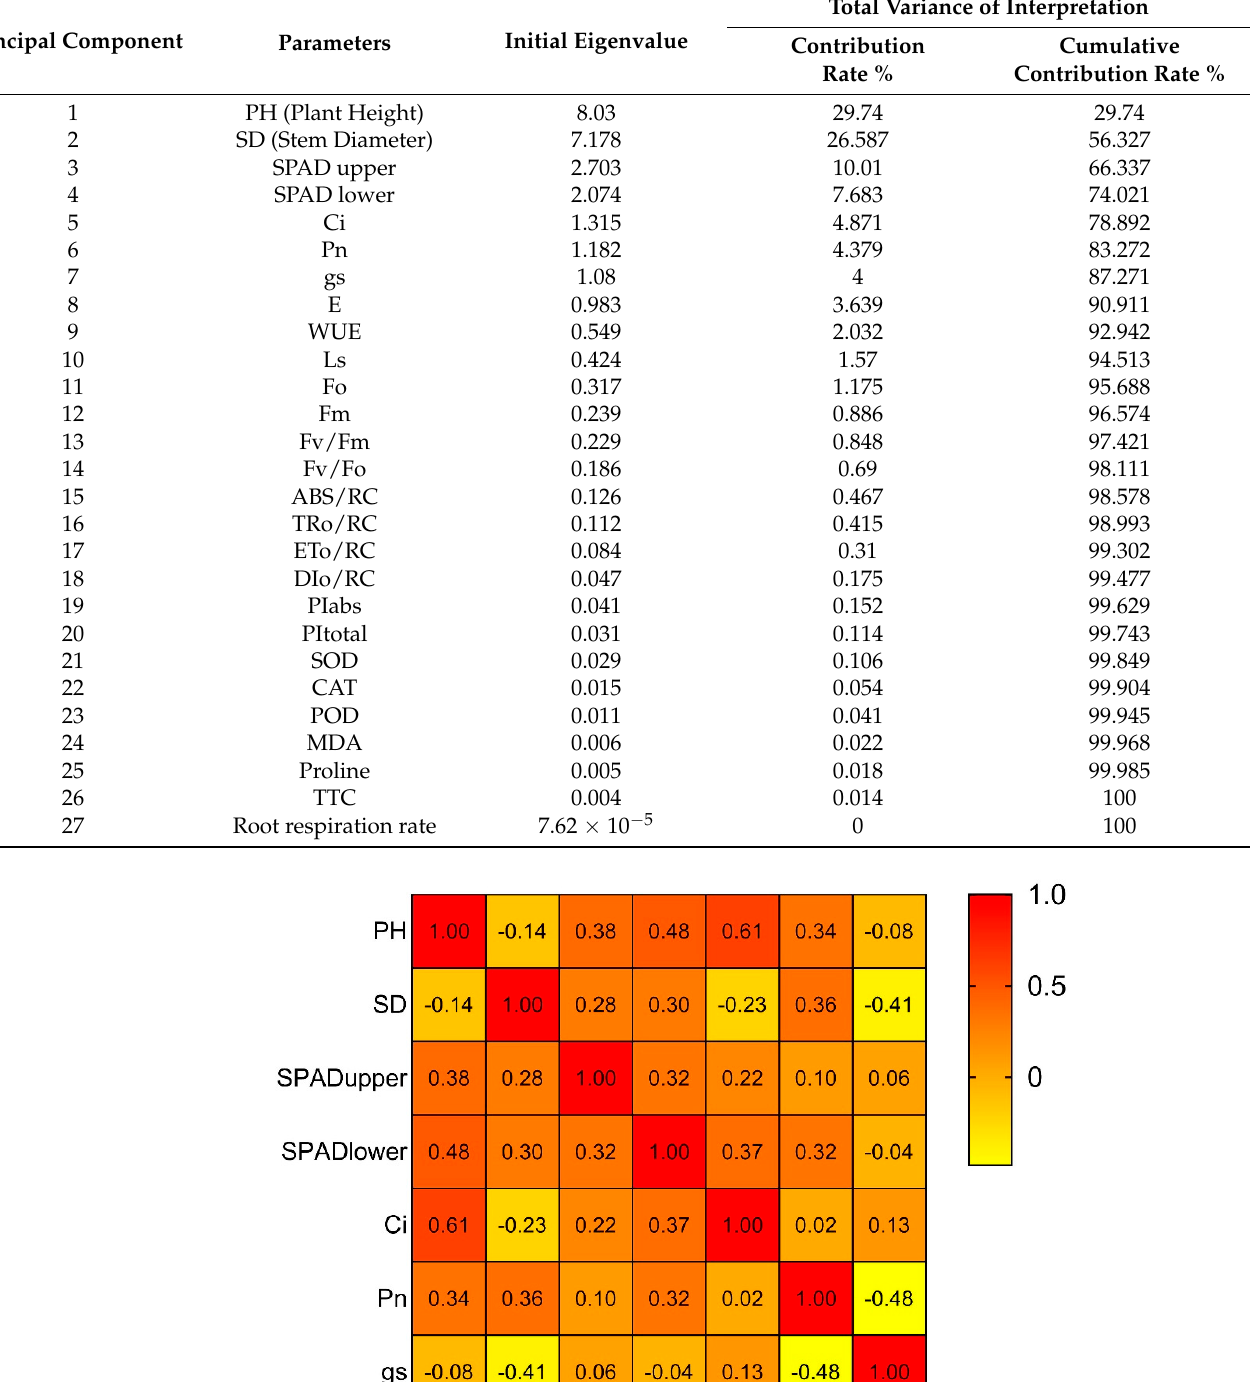
Table 5. Evaluation of waterlogging tolerance of different peach rootstocks based on a principal component analysis.